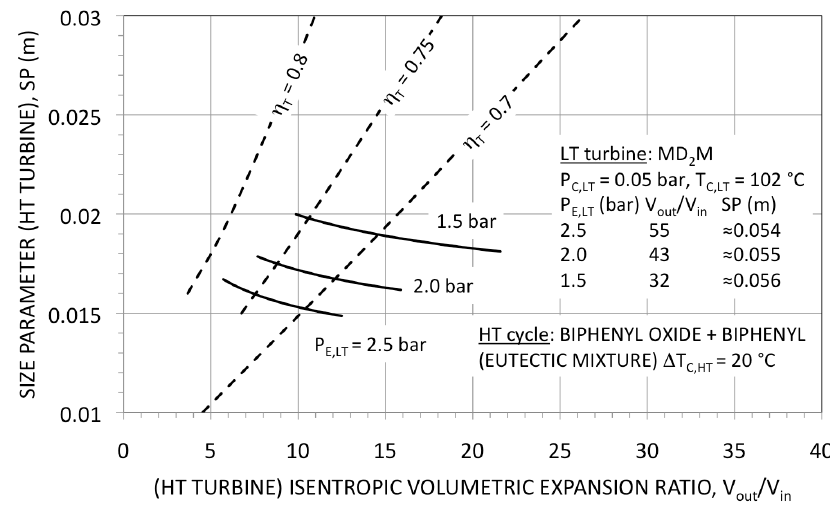
Figure 7. Size parameter and isentropic volumetric expansion ratio for the “High Temperature” turbine at different evaporation pressures P E , LT . The working fluid for the HT cycle is the eutectic mixture of biphenyl oxide and biphenyl. The solid lines are at different fixed evaporation pressures P E , LT = 1.5bar, 2bar and 2.5bar. Increasing the ratio ˙ V out / ˙ V in increases then the evaporation pressure of the HT cycle.